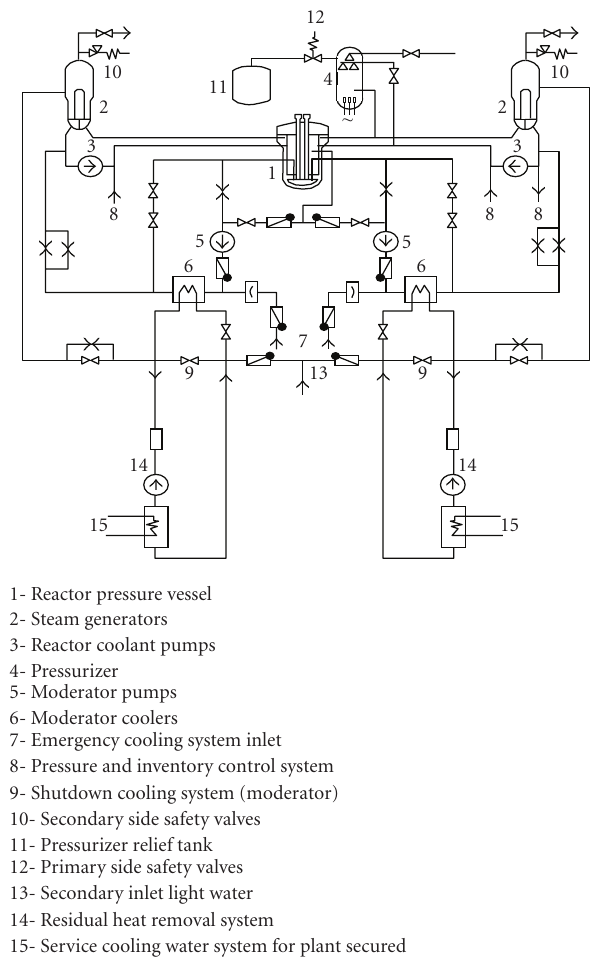
Figure 1: CNA-I PHWR NPP reactor cooling system and MOD sys-